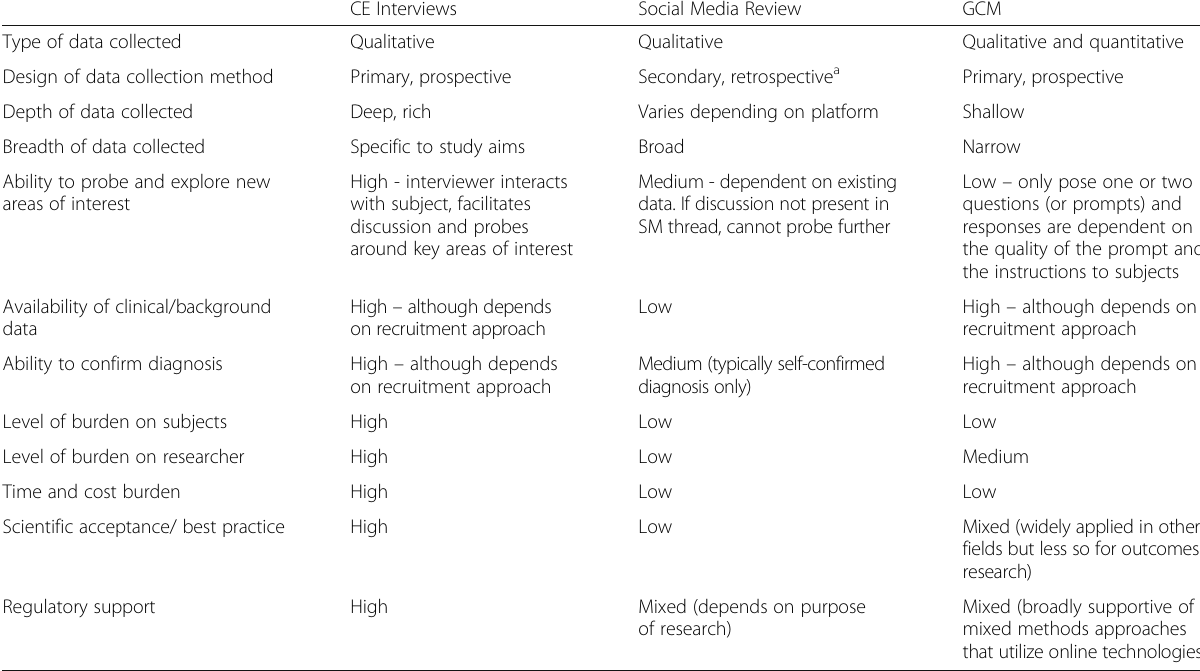
Table 1 Overview of methods under evaluation in this